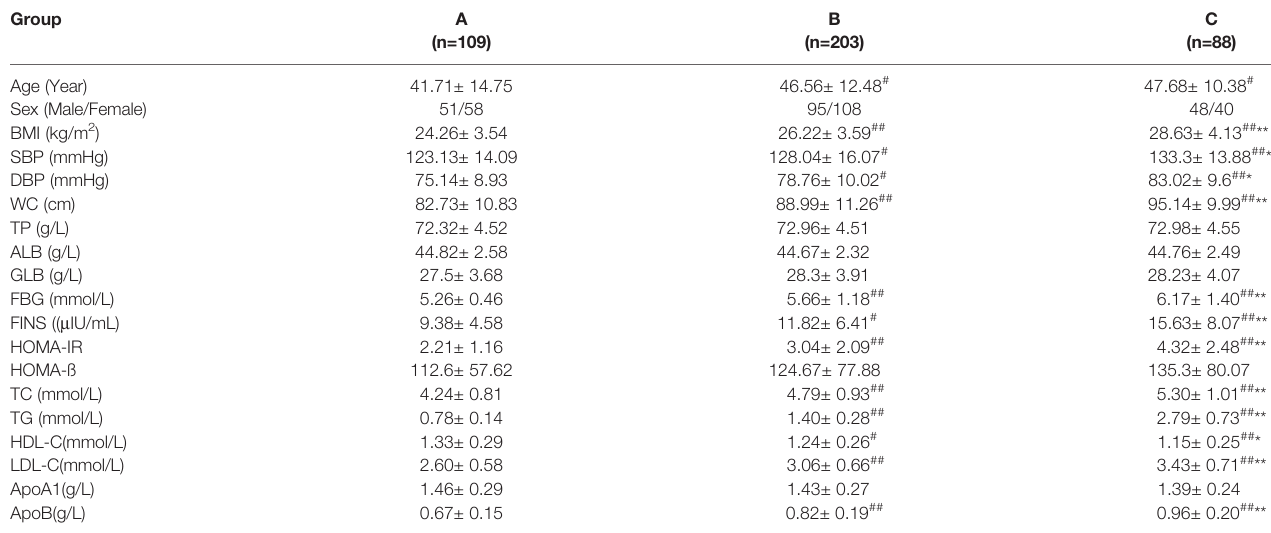
TABLE 1 | Basic parameters of groups with different FTG